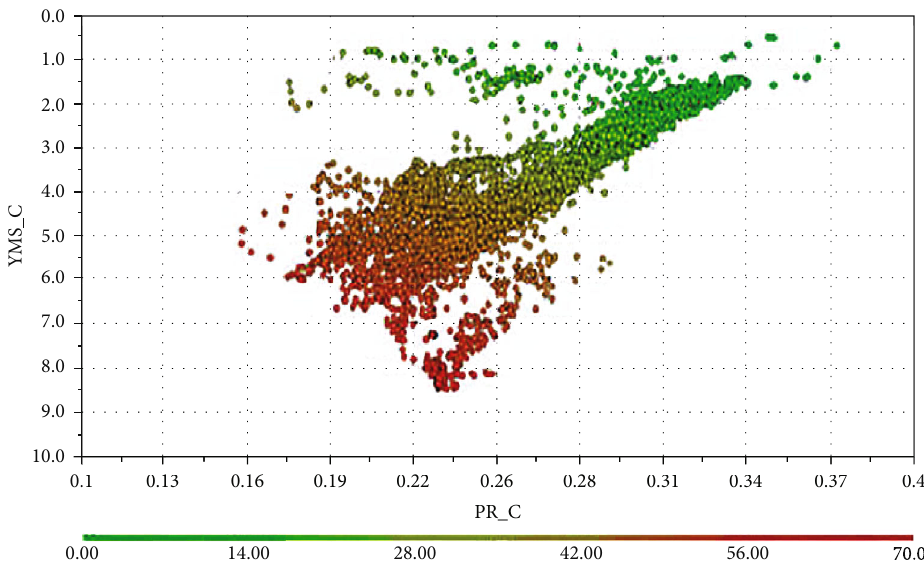
Figure 3: Intersection diagram of in fl uence of elastic modulus and Poisson ’ s ratio on brittleness [17].